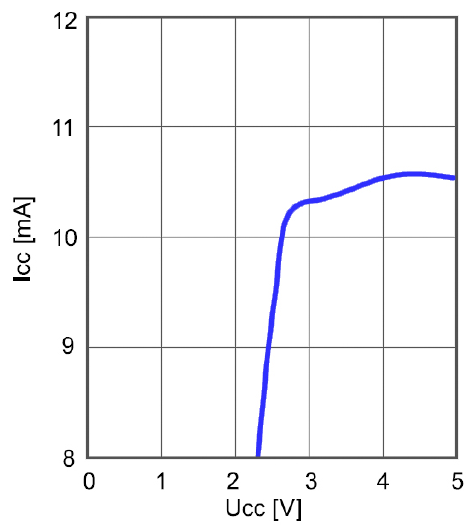
Figure 13. Power consumption of frequency mixer as a function of the supply voltage.